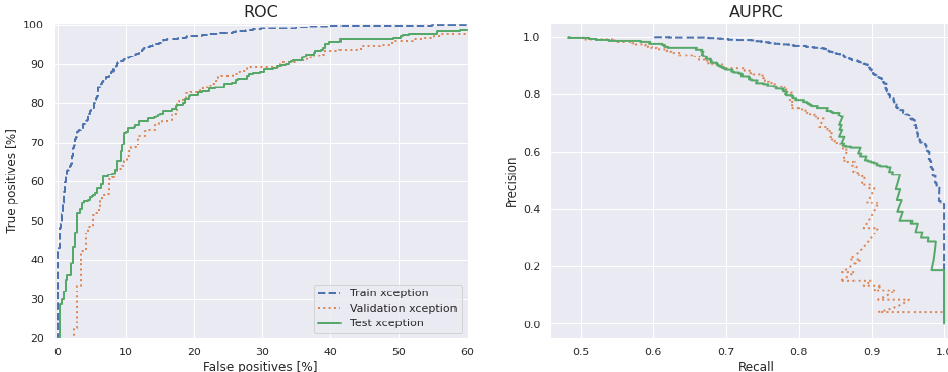
Figure 13. Classification results of the proposed ShuffleNet-Light, when Xception-v3 is deployed as a pretrained model with data augmentation.